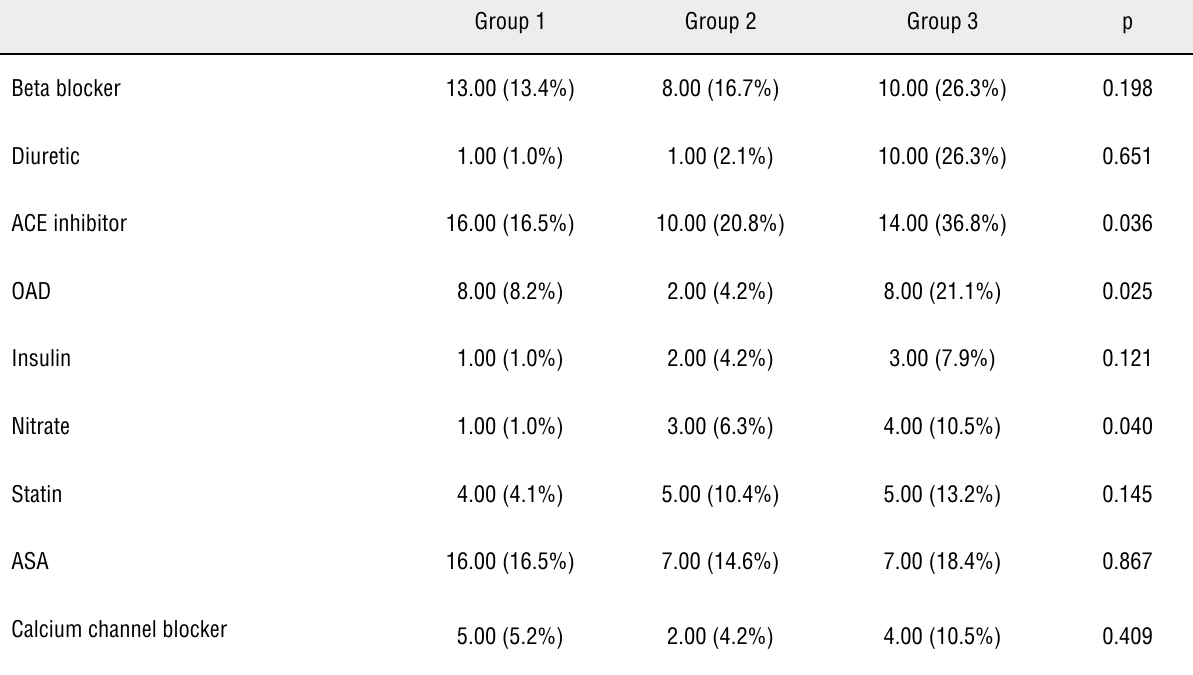
Table 2 - Situations of chronic drug use before MI.